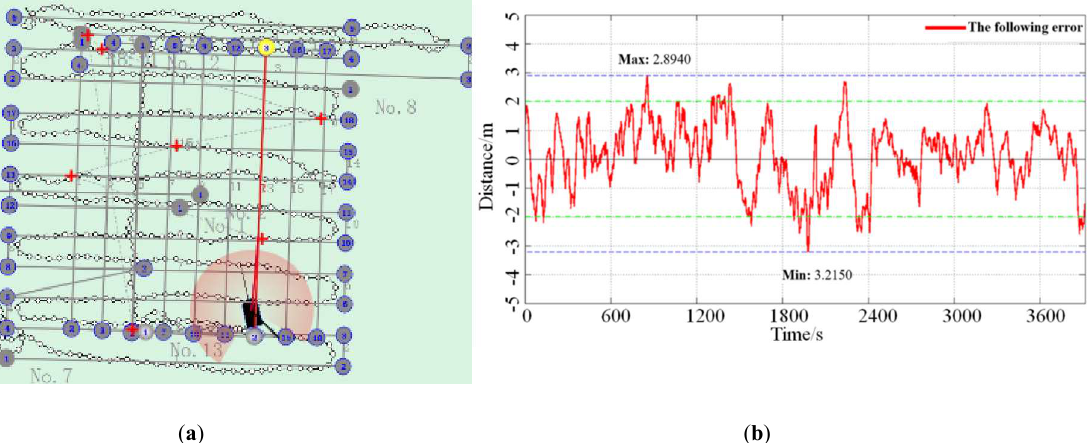
Figure 15. Path following error of the USV: ( a ) Path of the USV, ( b ) changes of the path following error during the mission.